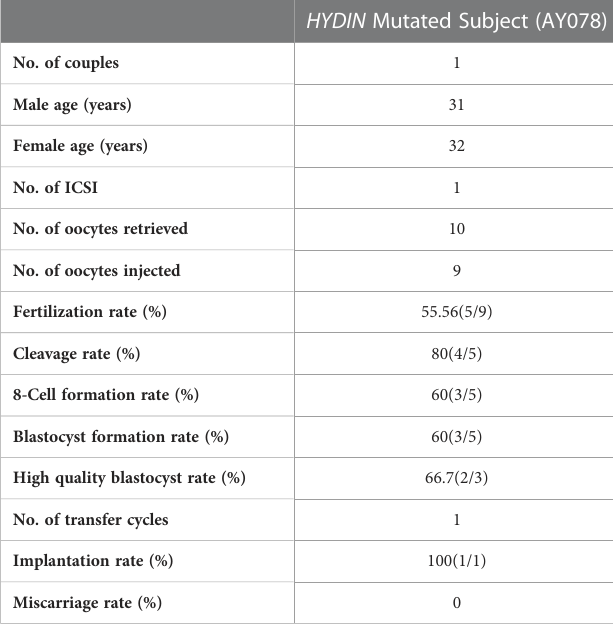
TABLE 3 The clinical outcomes of HYDIN mutated subject AY078.